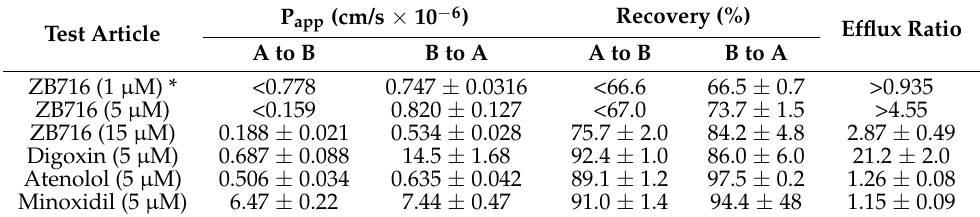
Table 8. Permeability results of ZB716 in Caco-2 cells (mean ± SD, n =